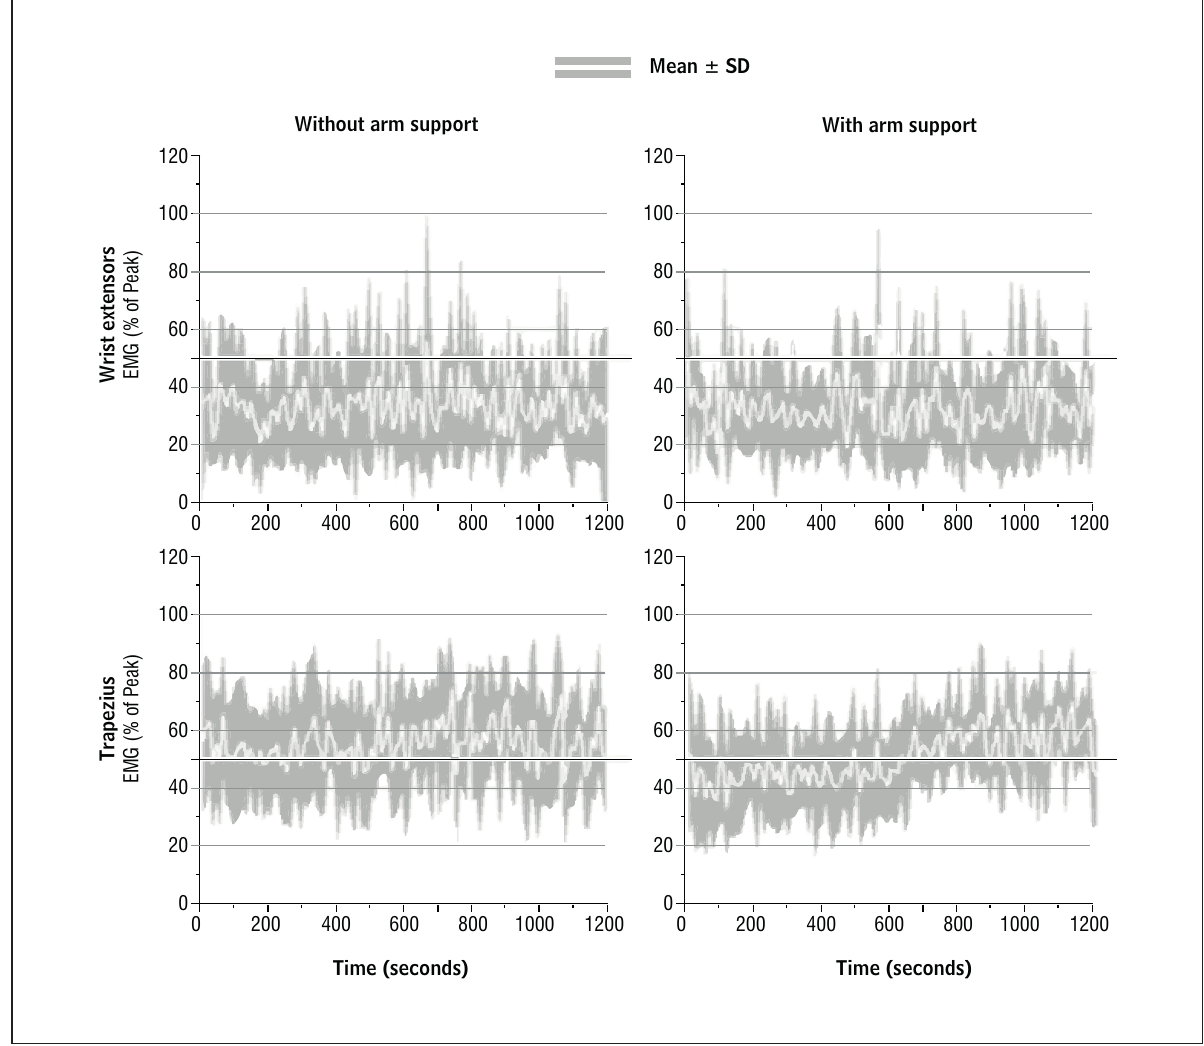
Figure 2 - Electromyographic signals (RMS) collected during the 20 minutes period of the occupational task Note: The signal was normalized by the peak value during the typewriting task. Solid horizontal lines were placed at 50% peak for interpreta- tion purposes. Source: Research